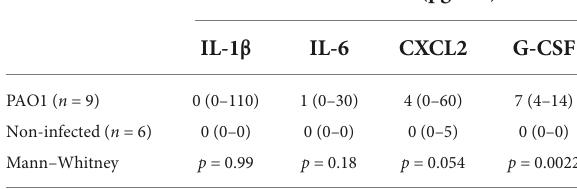
TABLE 2 Co-instillation of sIgY with bacteria reduces inflammatory cytokines in the